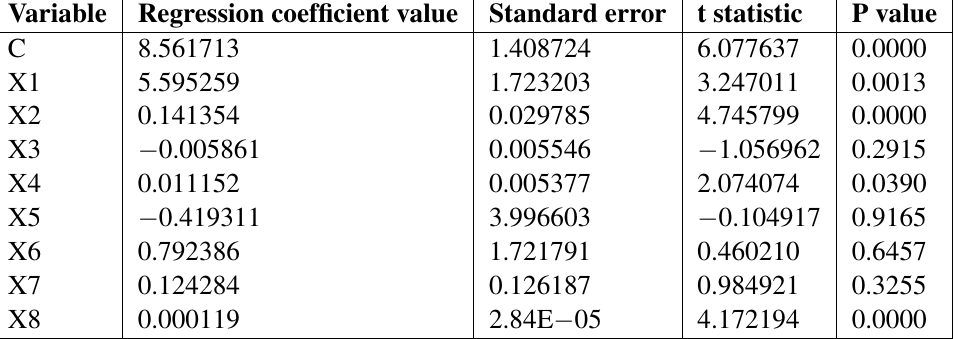
Table 2 Random influence variable intercept model estimation